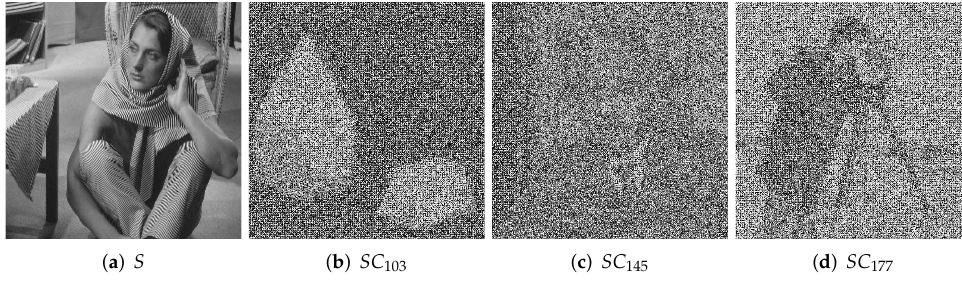
Figure 6. Experiment 1 of thumbnail secret sharing.